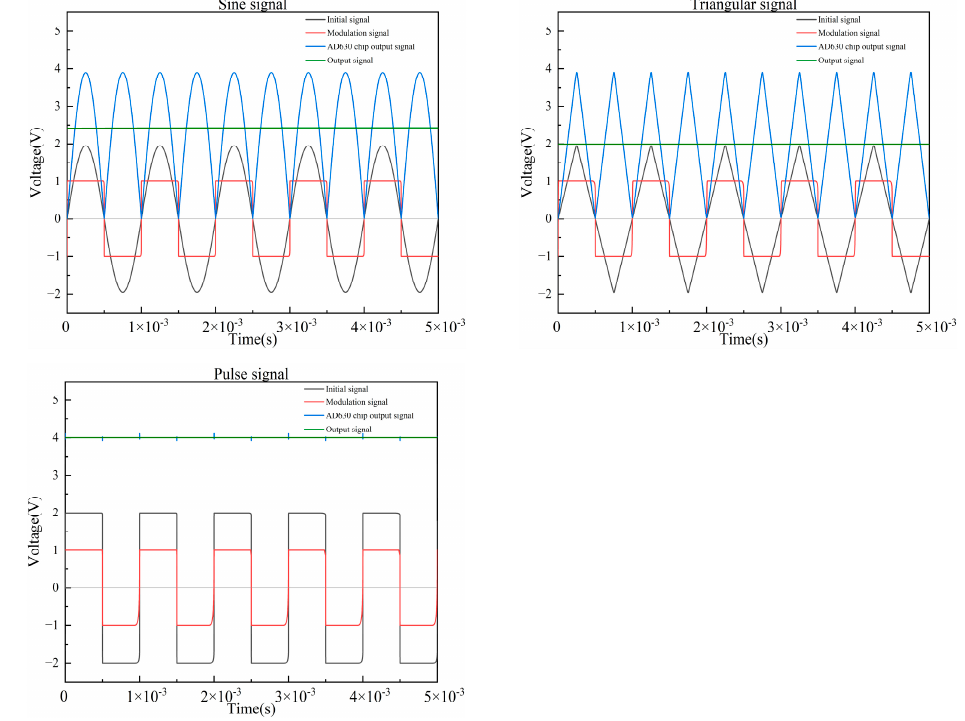
Figure 7. Demodulation principle of three excitation signals.